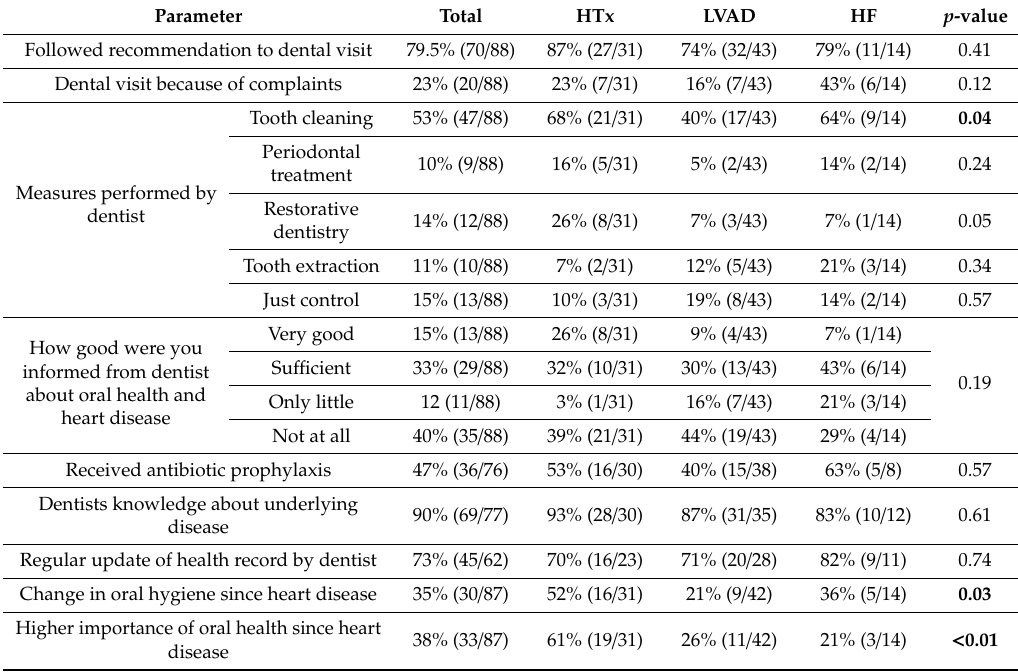
Table 5. Results of the questionnaire regarding dental consultation. Values are given as % ( n ) significance level: p <